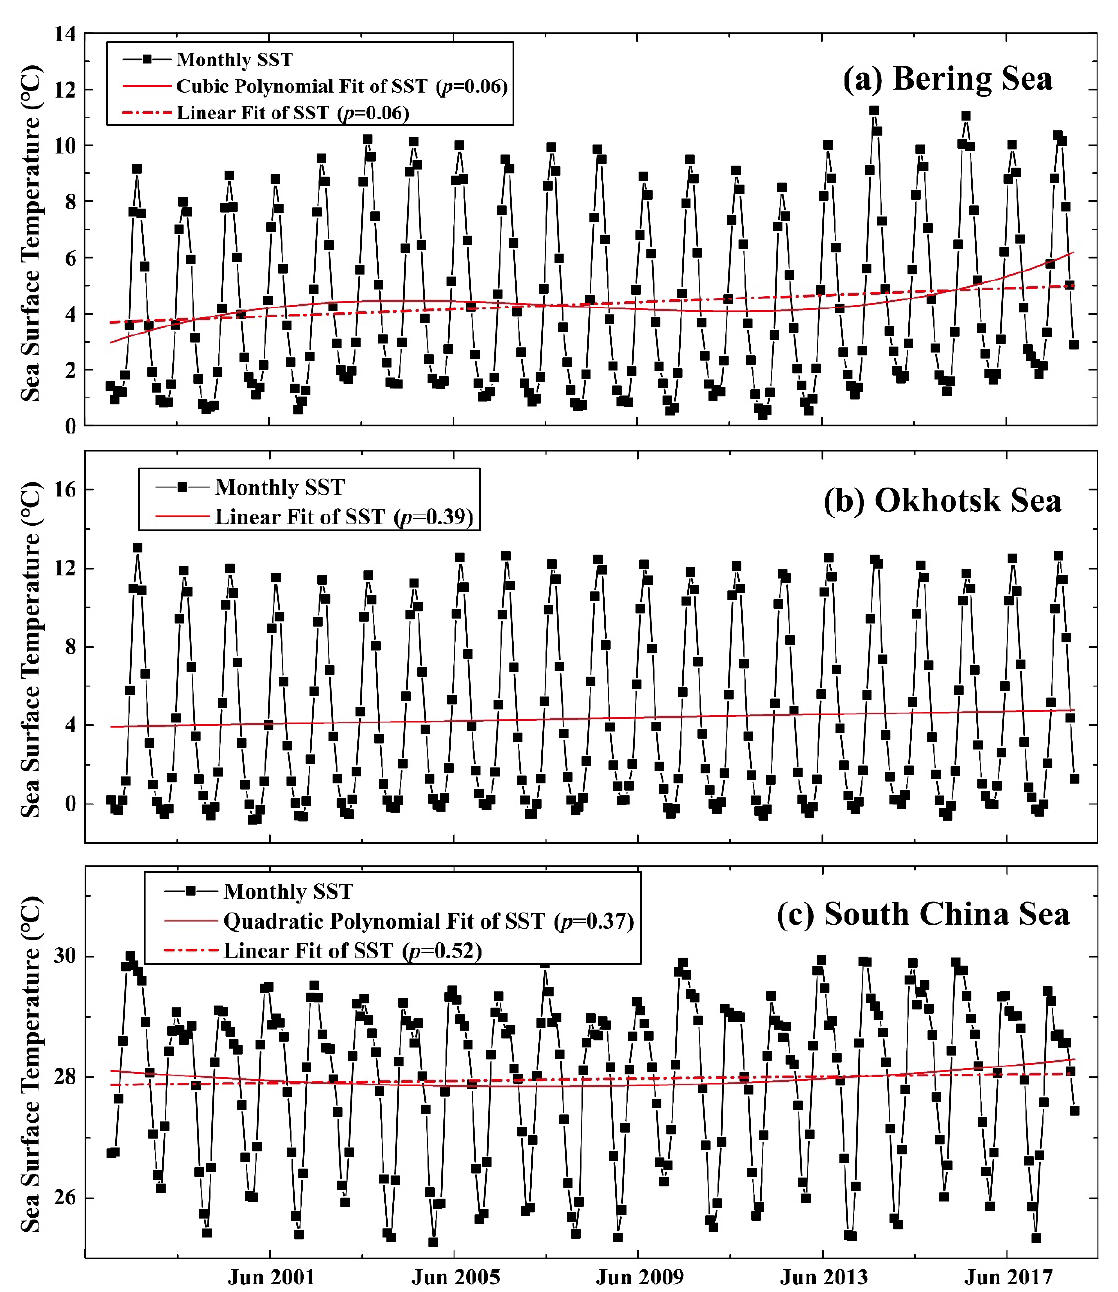
Figure 2. SST time series in the ( a ) Bering, ( b ) Okhotsk, and ( c ) South China Seas during 1998–2018.